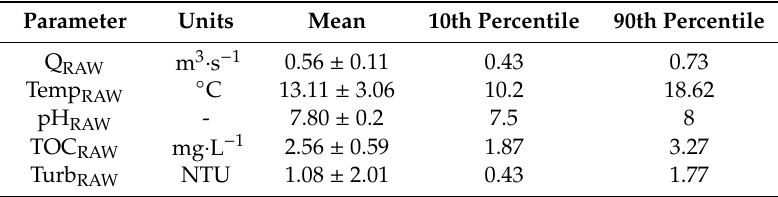
Table 1. Main characteristics of the Montfull à DWTP raw water parameters (1 January 2014–31 December